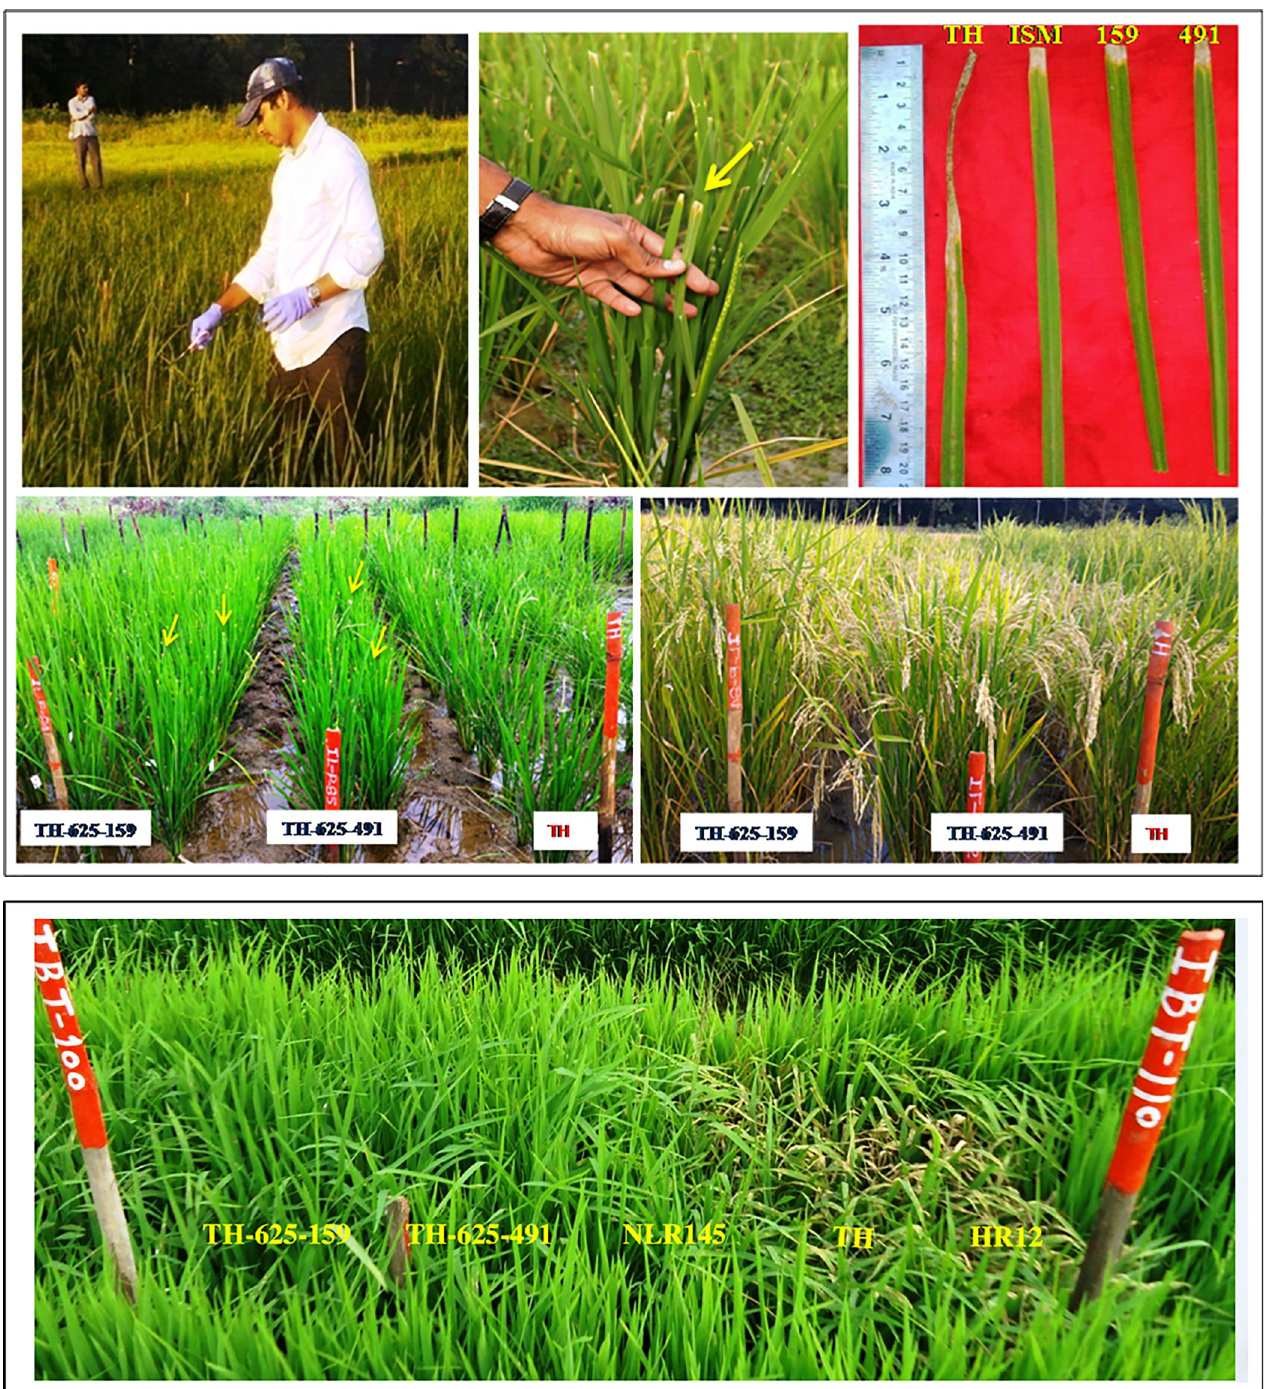
Fig 4. a: BB screening of ICF 3 (TH-625-159 & TH-625-491) lines at ARI, Hyderabad, During Kharif , 2015–16. Screening of selected ICF 3 (TH-625-159 & TH- 625-491) lines having Xa21+xa13+Pi54+Pi1 genes against local BB isolate (DX-020). ICF 3 progenies were highly resistant against BB isolate (DX-020). TH: Tellahamsa- Recurrent parent (Susceptible); ISM: Improved Samba Mahsuri (Resistant); 159 and 491: ICF 3 progenies (TH-625-159 and TH-625-491). b: Blast screening of ICF 3 (TH-625-159 & TH-625-491) lines at IIRR, Hyderabad, During Kharif , 2015–16. Screening of selected ICF 3 (TH-625-159 & TH-625-491) lines having Xa21+xa13+Pi54+Pi1 genes against local blast isolate (NLR-1). ICF 3 lines were highly resistant against blast isolate (NLR-1). TH: Tellahamsa- Recurrent parent (Susceptible); NLR145- (Resistant check); HR12- (Susceptible check); 159 and 491: ICF 3 lines (TH-625-159 and TH-625-491).